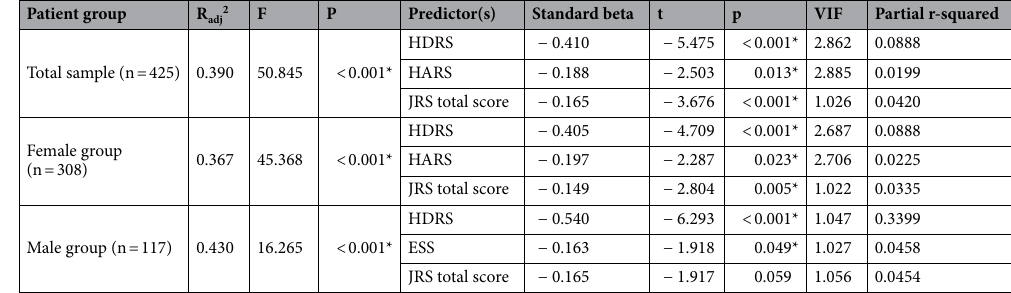
Table 4. Results of backward stepwise linear regression analyses for predictors in HRQoL with the clinical variables in total BSP patient group, and female and male patient subgroups. HDRS, Hamilton Rating Scale for Depression; HARS, Hamilton Rating Scale for Anxiety; JRS total score, Jankovic rating total score; ESS, Epworth Sleepiness Scale. *Significant